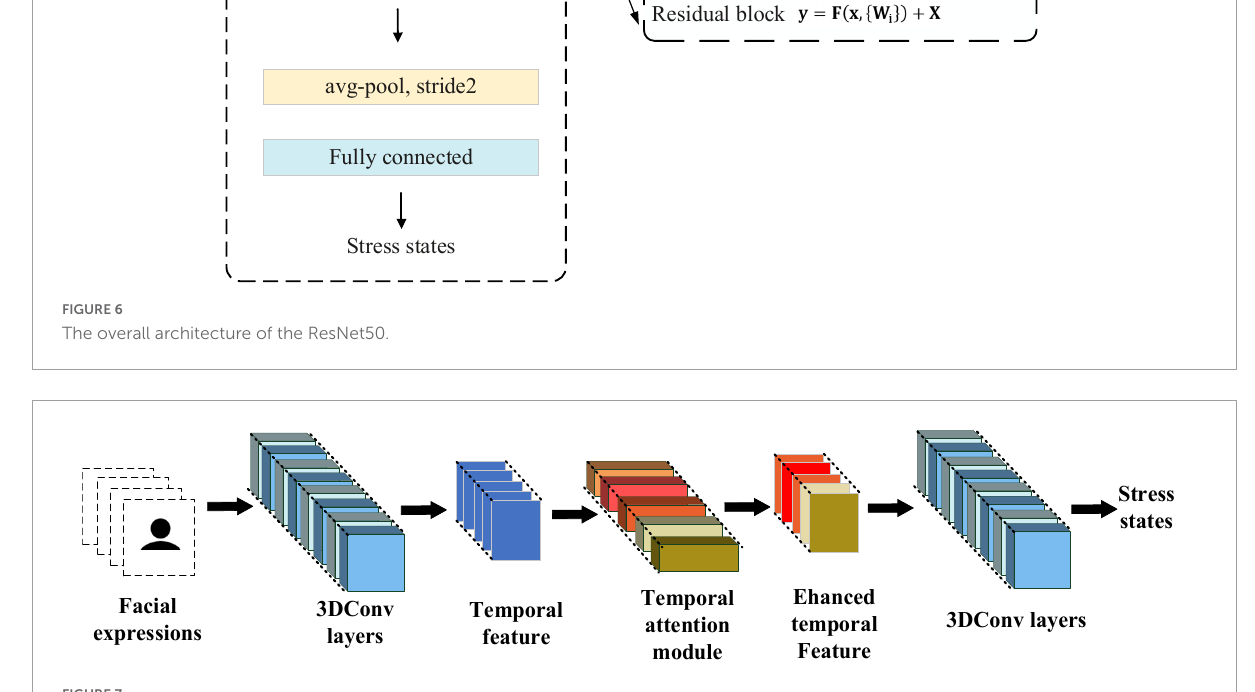
FIGURE7 3D convolution strategy for facial expressions input in this work.